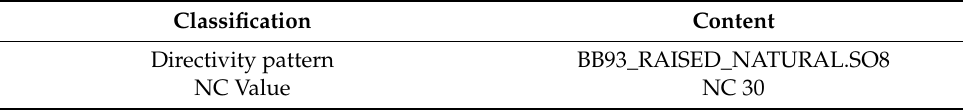
Table 4. General information of acoustical setting in Odeon.